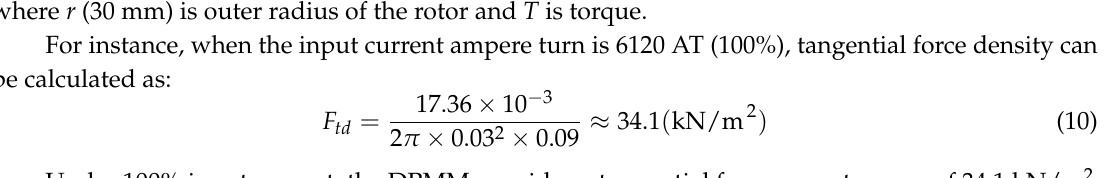
Figure 3. Tangential force density comparison for different input currents.